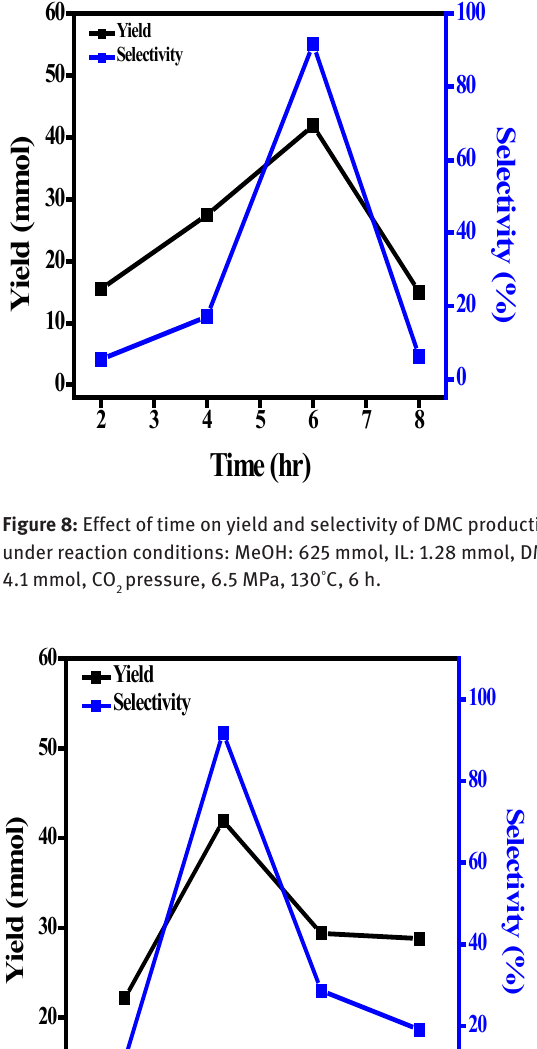
Figure 7: Effect of pressure on yield and selectivity of DMC production under reaction conditions: MeOH: 625 mmol, IL: 1.28